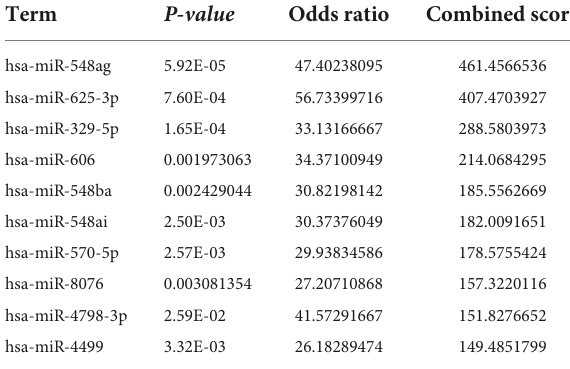
TABLE 2 MicroRNA targets of 21 ferroptosis-related genes in